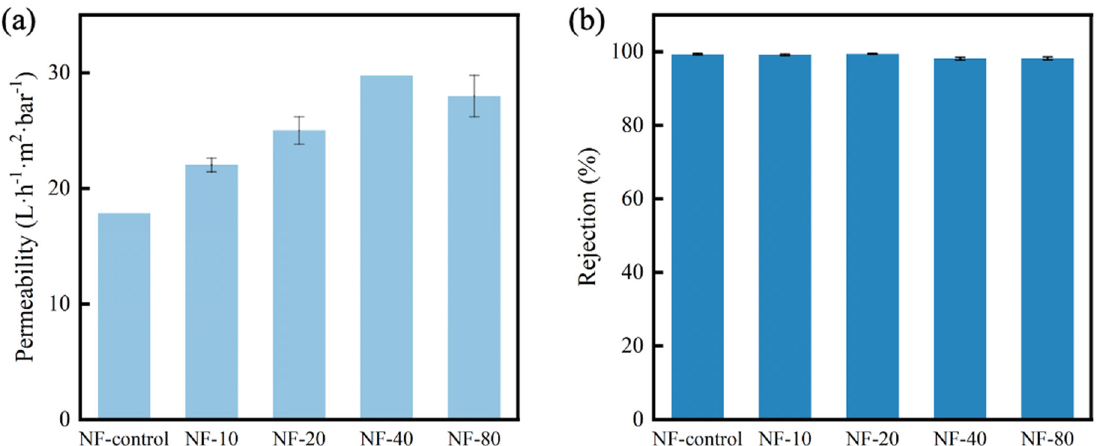
Figure 9. The separation properties of membranes with different concentrations CaCl 2 added in the post-treatment: ( a ) water permeability, ( b ) Na 2 SO 4 rejection.